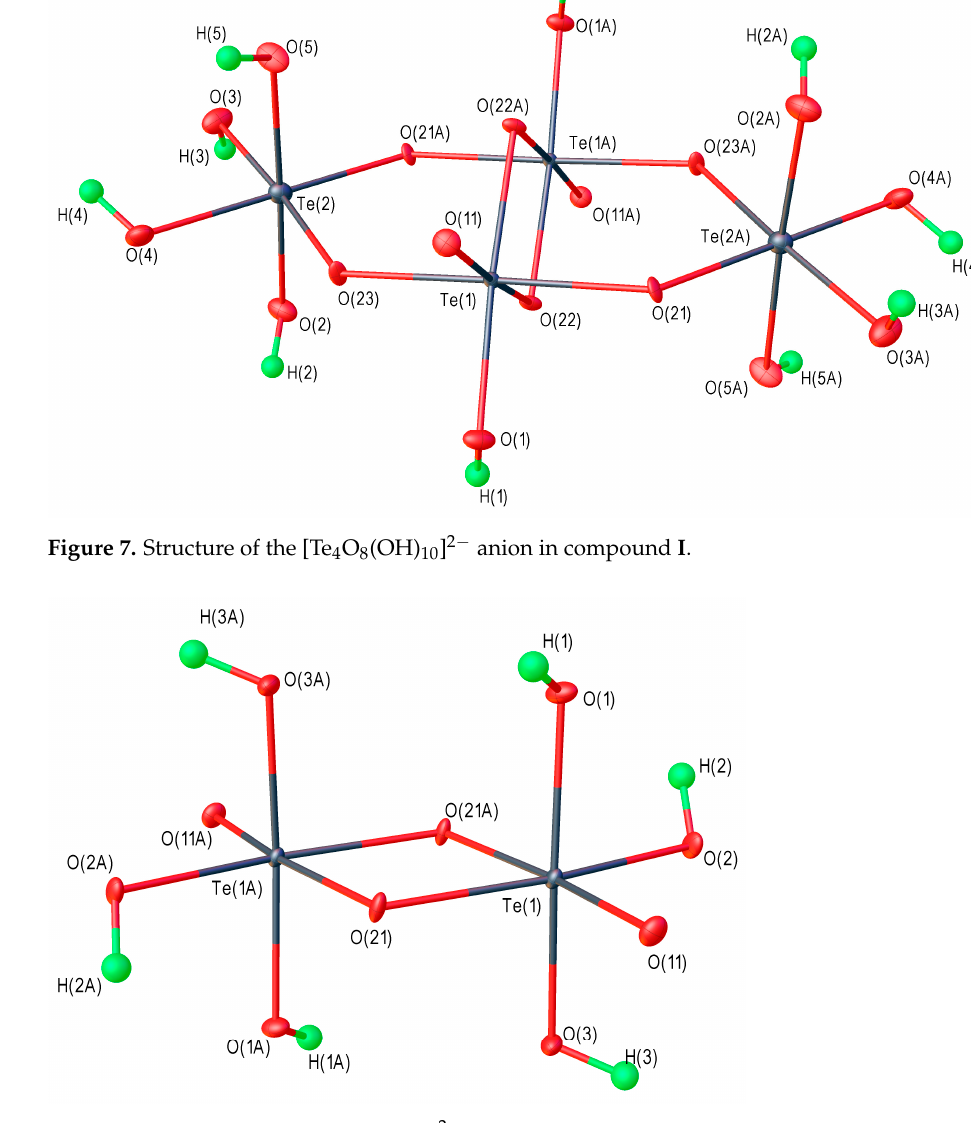
Figure 8. Structure of the [Te 2 O 4 (OH) 6 ] 2 − anion in compound II .